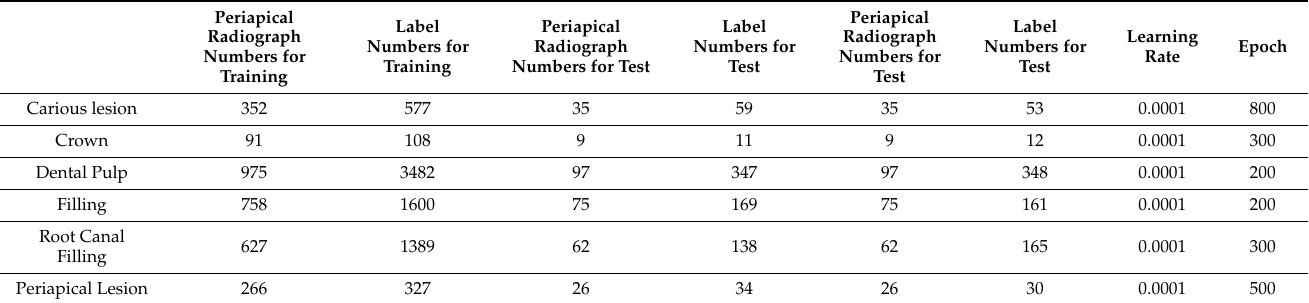
Table 1. Data distribution and training parameters.